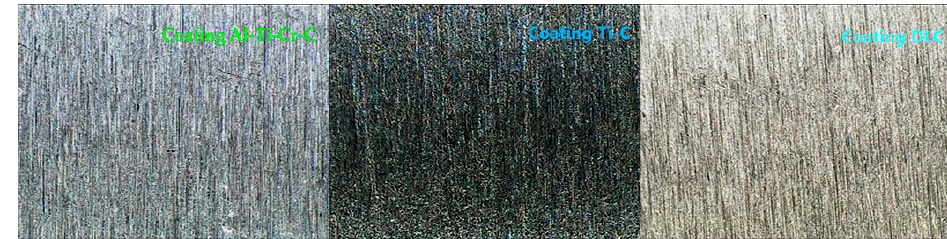
Figure 3. Surface morphology of the spindles.